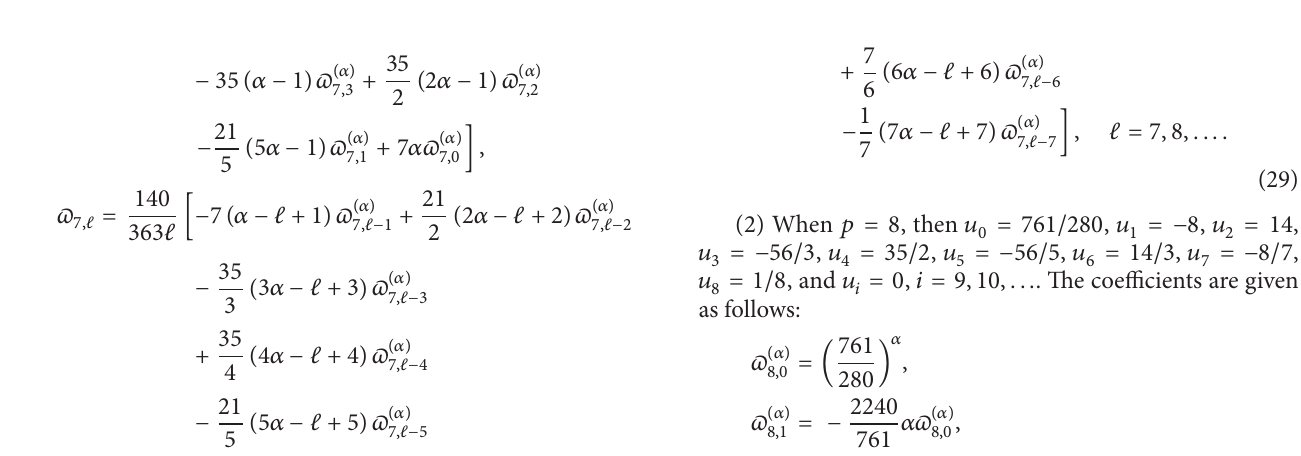
Figure 9: The exact value of 7 for 𝛼 = 0.5 and step length of ℎ = 1/120